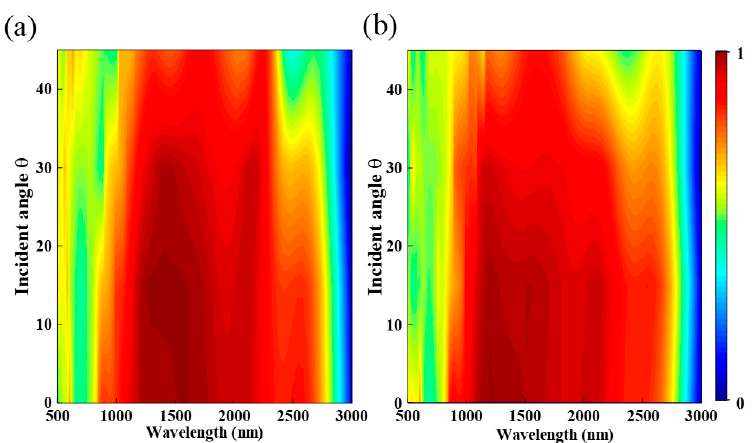
Figure 8. Absorption spectra at different incidence angles under ( a ) TE and ( b ) TM polarizations.